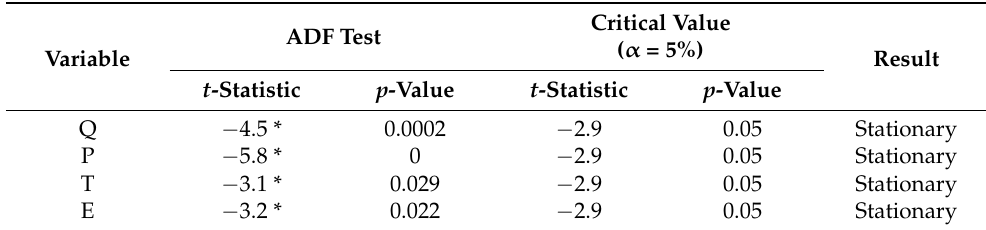
Table 4. Results of the ADF test of each factor.